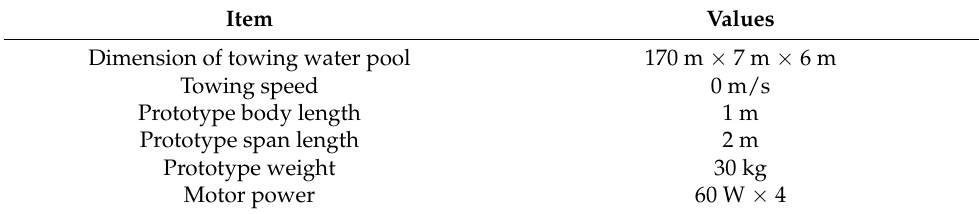
Table 2. Main technical parameters of the experimental